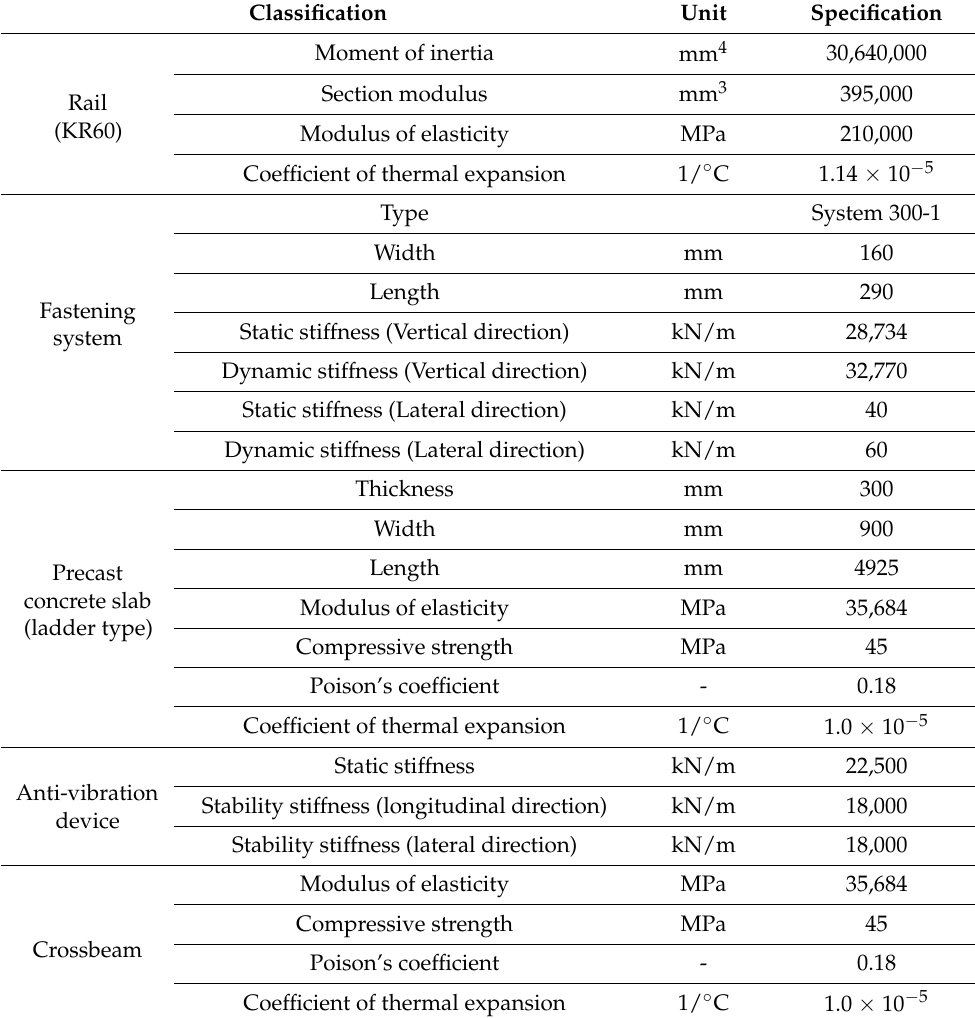
Table 3. Specification of track